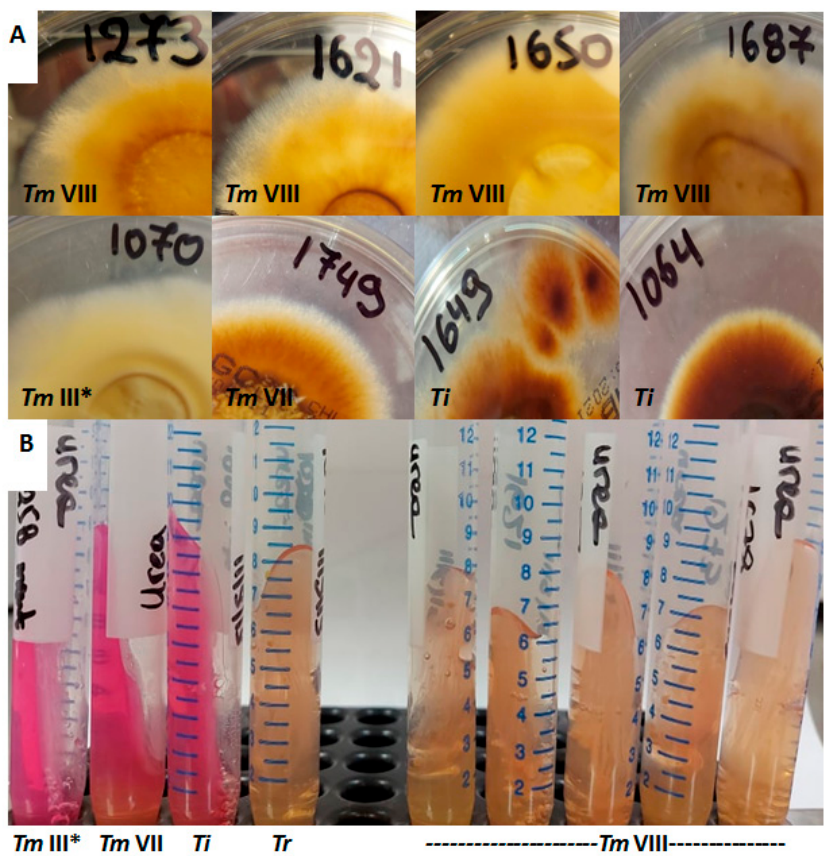
Figure 2. ( A ) Colonies of all but one (Nr.1687) T. mentagrophytes ITS Type VIII ( Tm VIII) isolates had yellowish reverse pigment (upper line), as opposed to T. interdigitale ( Ti ) as well as T. mentagrophytes Type III* ( Tm III*) and Type VII ( Tm VII) isolates (lower line). ( B ) Urease test on Christensen urease agar was positive for T. interdigitale and T. mentagrophytes ITS Type III* and Type VII, but negative for T. rubrum ( Tr ) and T. mentagrophytes Type VIII after 7 days of incubation.